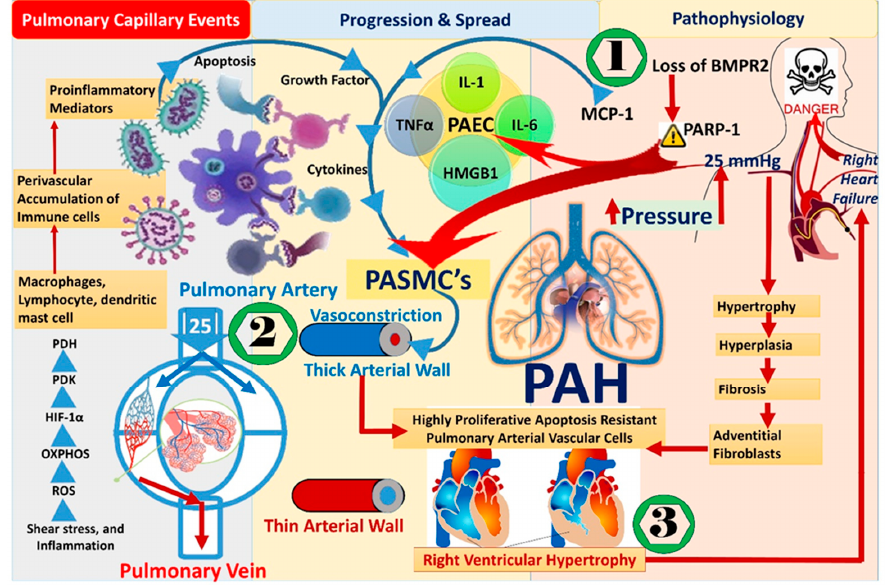
Figure 2. Pathological hallmarks of pulmonary arterial hypertension including events at capillary level, progression, and spread. (1) Events at the genetic level, (2) events at pulmonary artery smooth muscle cells. (3) Events leading to right heart failure (blue arrows represents molecular pathogenesis, and red arrows represents cellular impairment).